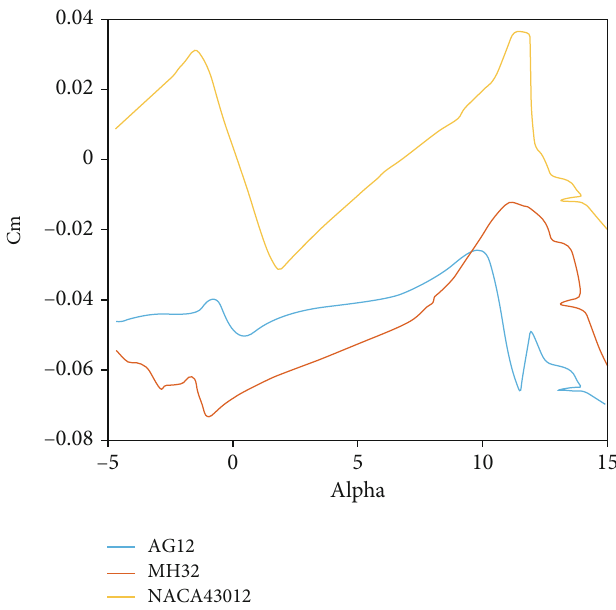
Figure 6: Coe ffi cient of pitching